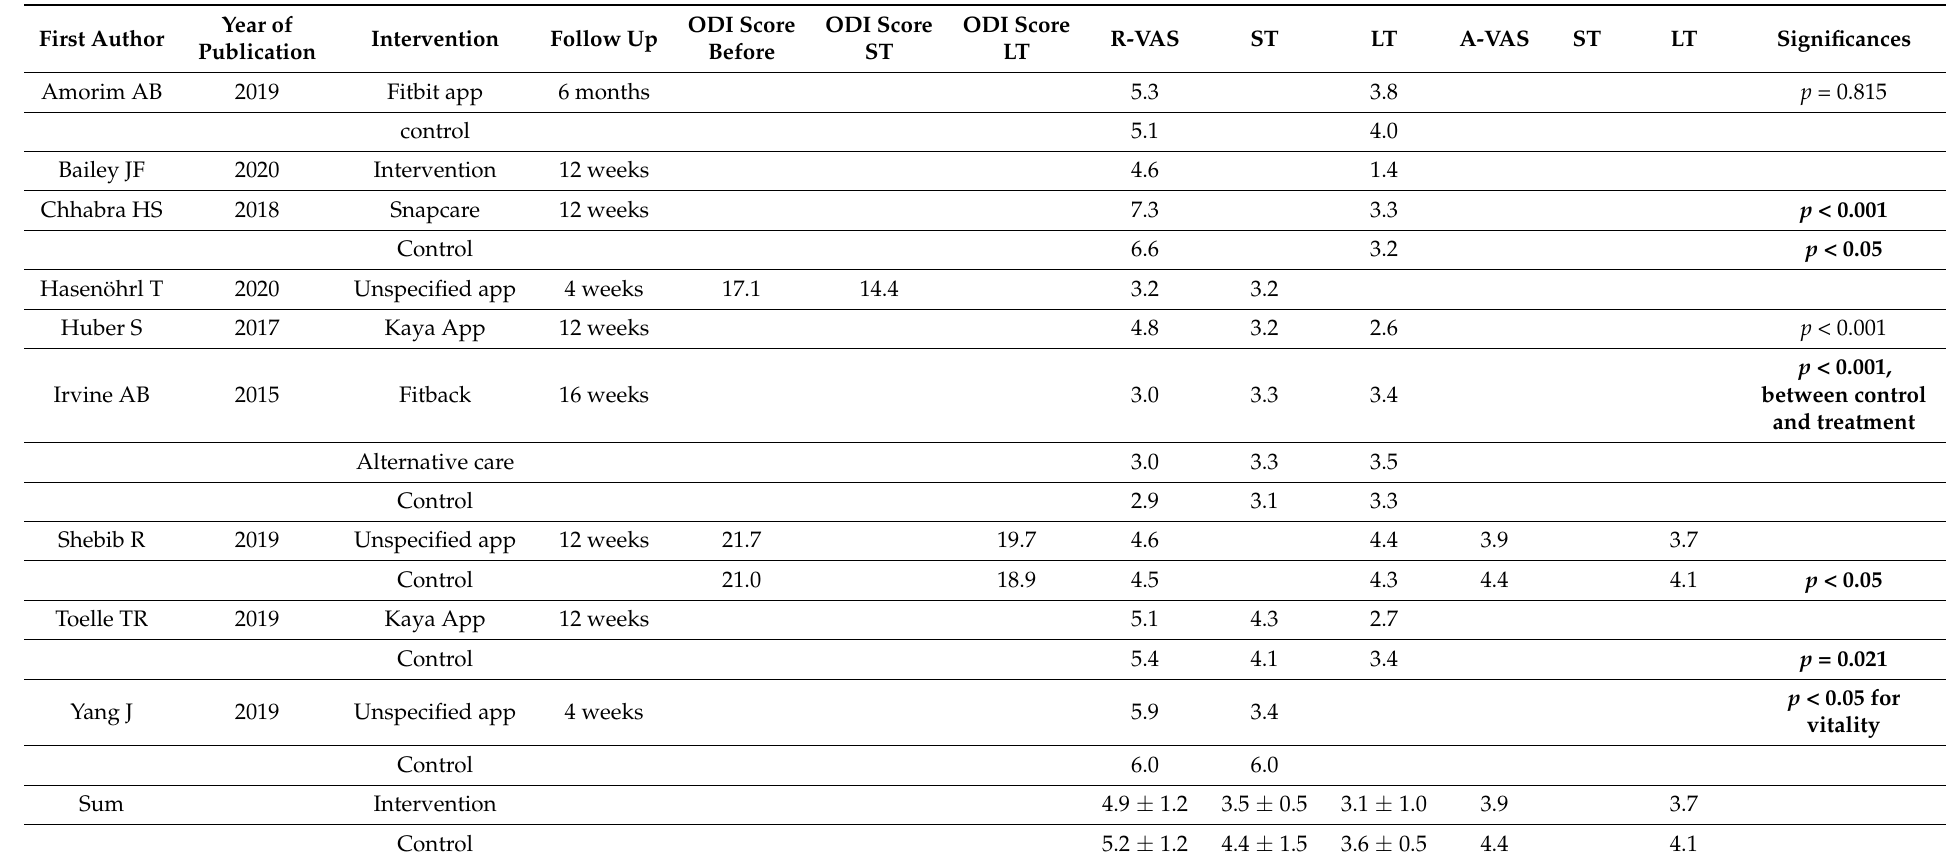
Table 3. Indication, Oswestry score and VAS of pain; overall means, standard deviations and p -values. R-VAS—visual analogue scale of pain at rest, A-VAS—visual analogue scale of pain during activity, LT—long term, ST—short